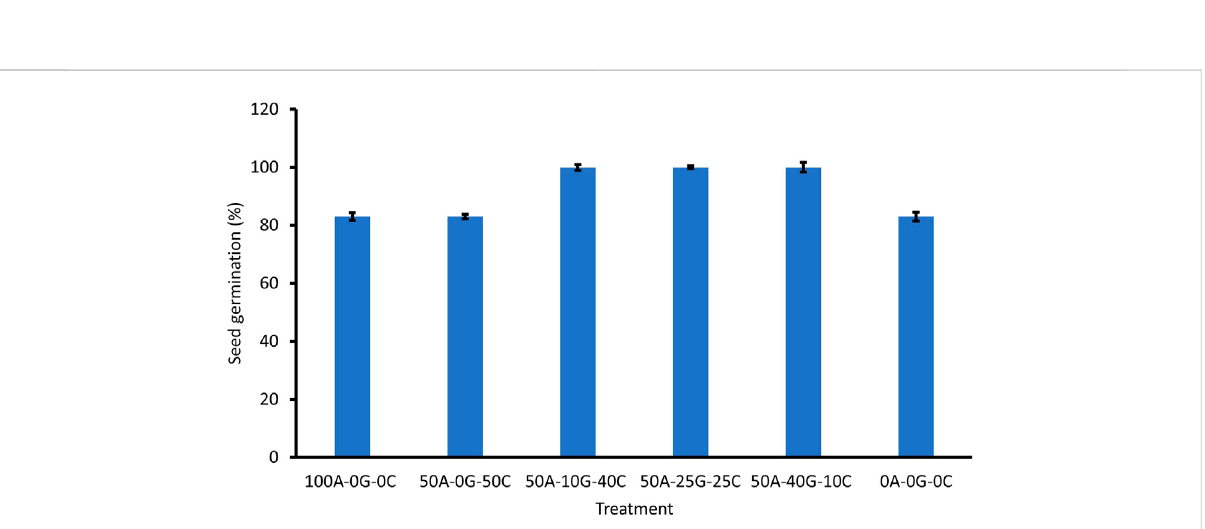
FIGURE 2 Effect of treatment group on growth at 34 days. Error bars correspond to standard deviation. 100A-0G-0C (Positive control) — 100% sodium alginate, 0% glomalin, 0% Chlorella vulgaris 50A-0G-50C — 50% sodium alginate, 0% glomalin, 50% Chlorella vulgaris 50A-10G-40C — 50% sodium alginate, 10% glomalin, 40% Chlorella vulgaris 50A-25G-25C — 50% sodium alginate, 25% glomalin, 25% Chlorella vulgaris 50A-40G-10C — 50% sodium alginate, 40% glomalin, 10% Chlorella vulgaris 0A-0G-0C (Negative control)- sterile glass beads with a similar